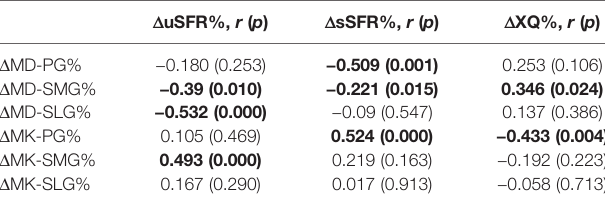
r represents correlation coef fi cient. The bold values represent